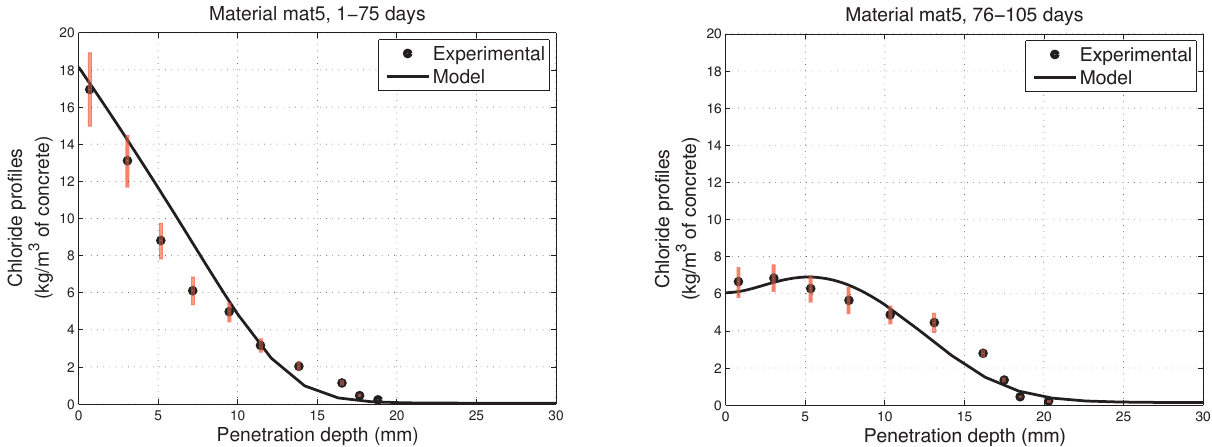
Figure 5. Experimental versus numerical solution for material mat5 and environments 1 (1–75 days) and 2 (76–105 days).